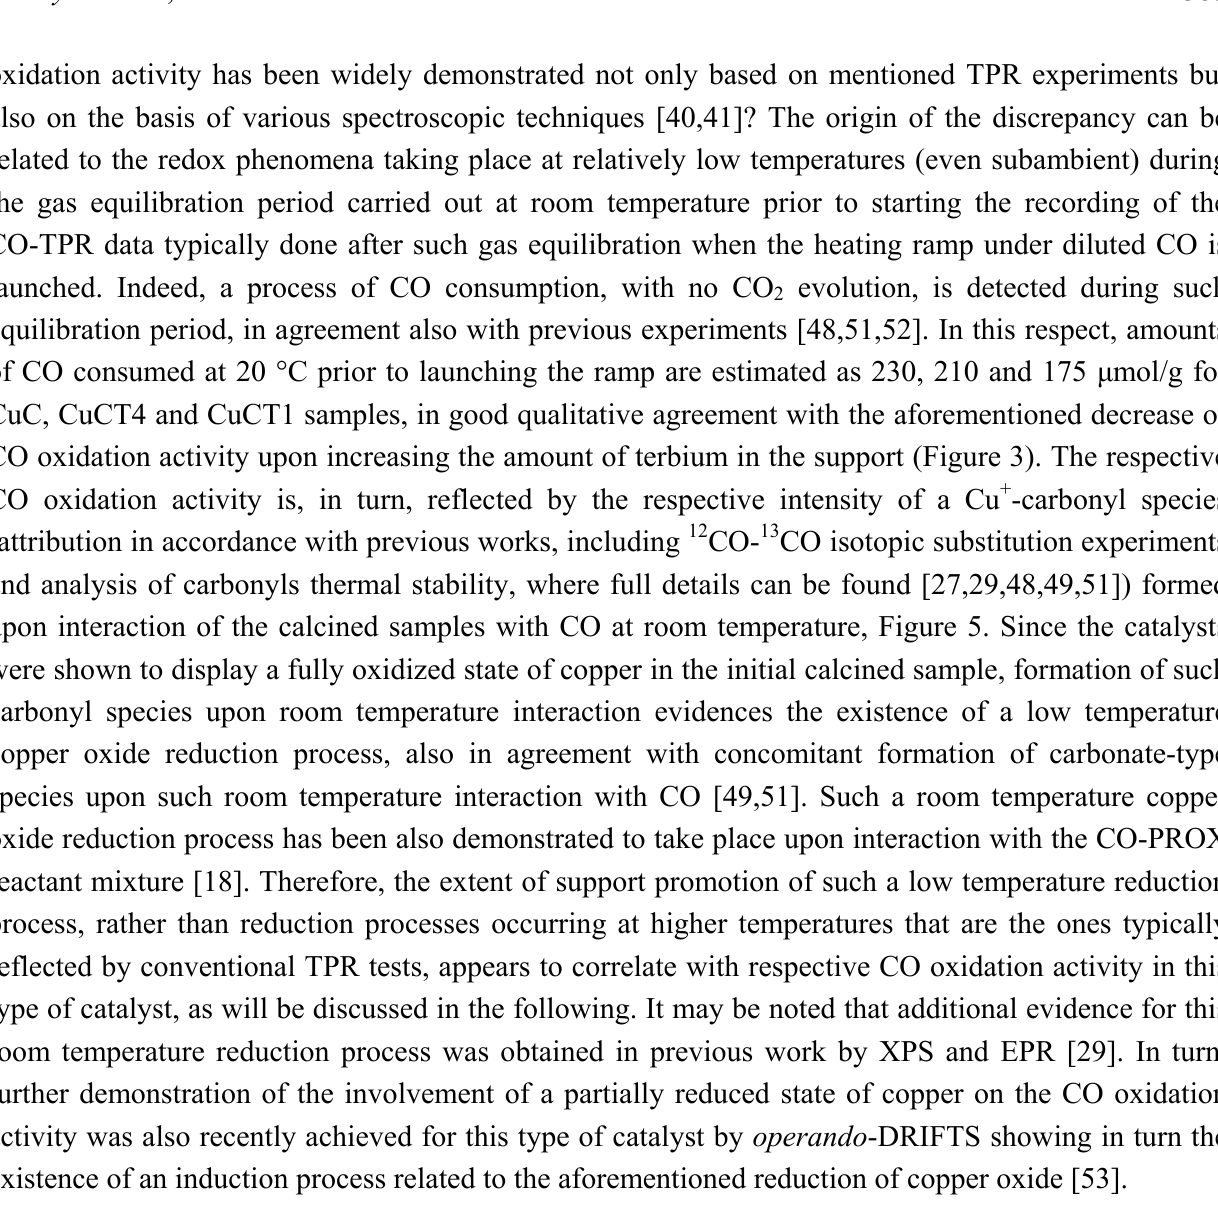
Figure 5. DRIFTS spectra in the carbonyl stretching region following interaction of the indicated catalysts with a diluted CO flow at room